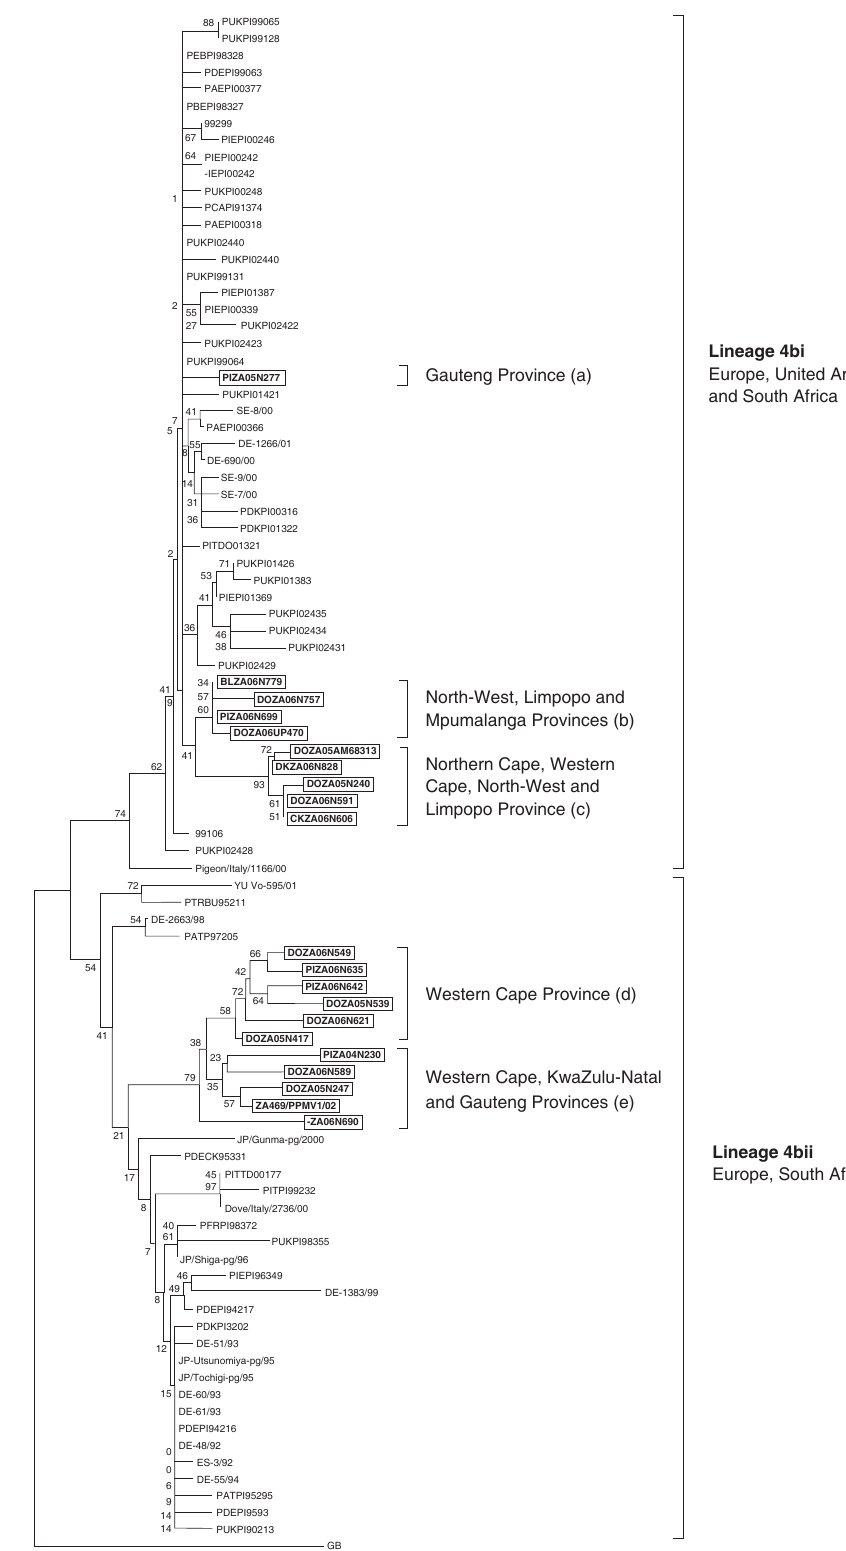
FIG.1 Phylogenetic tree of a 374-bp region of the fusion protein gene of PPMV-1 viruses. South African strains are framed (bold